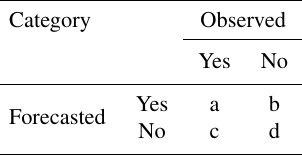
Table 2. Definition of categories for a binary event.